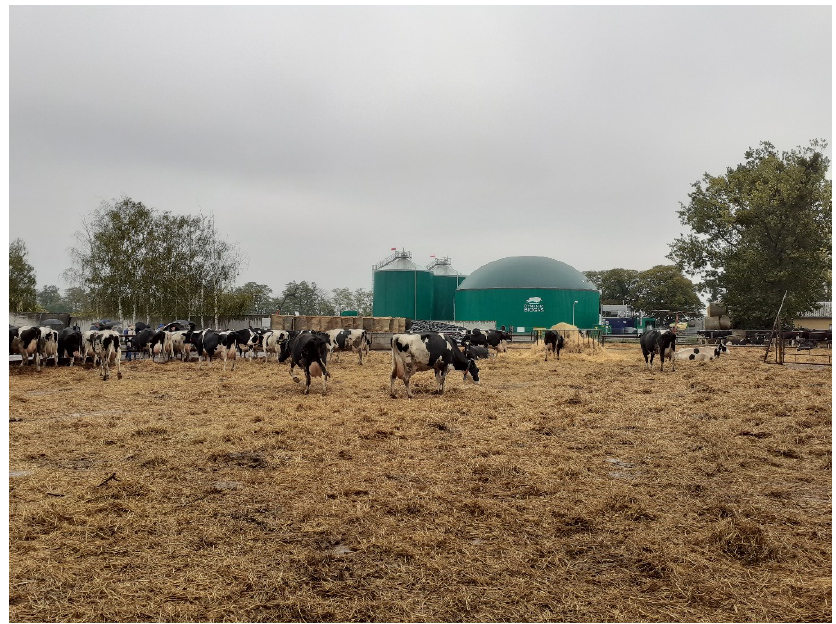
Figure 1. Agricultural biogas plant.